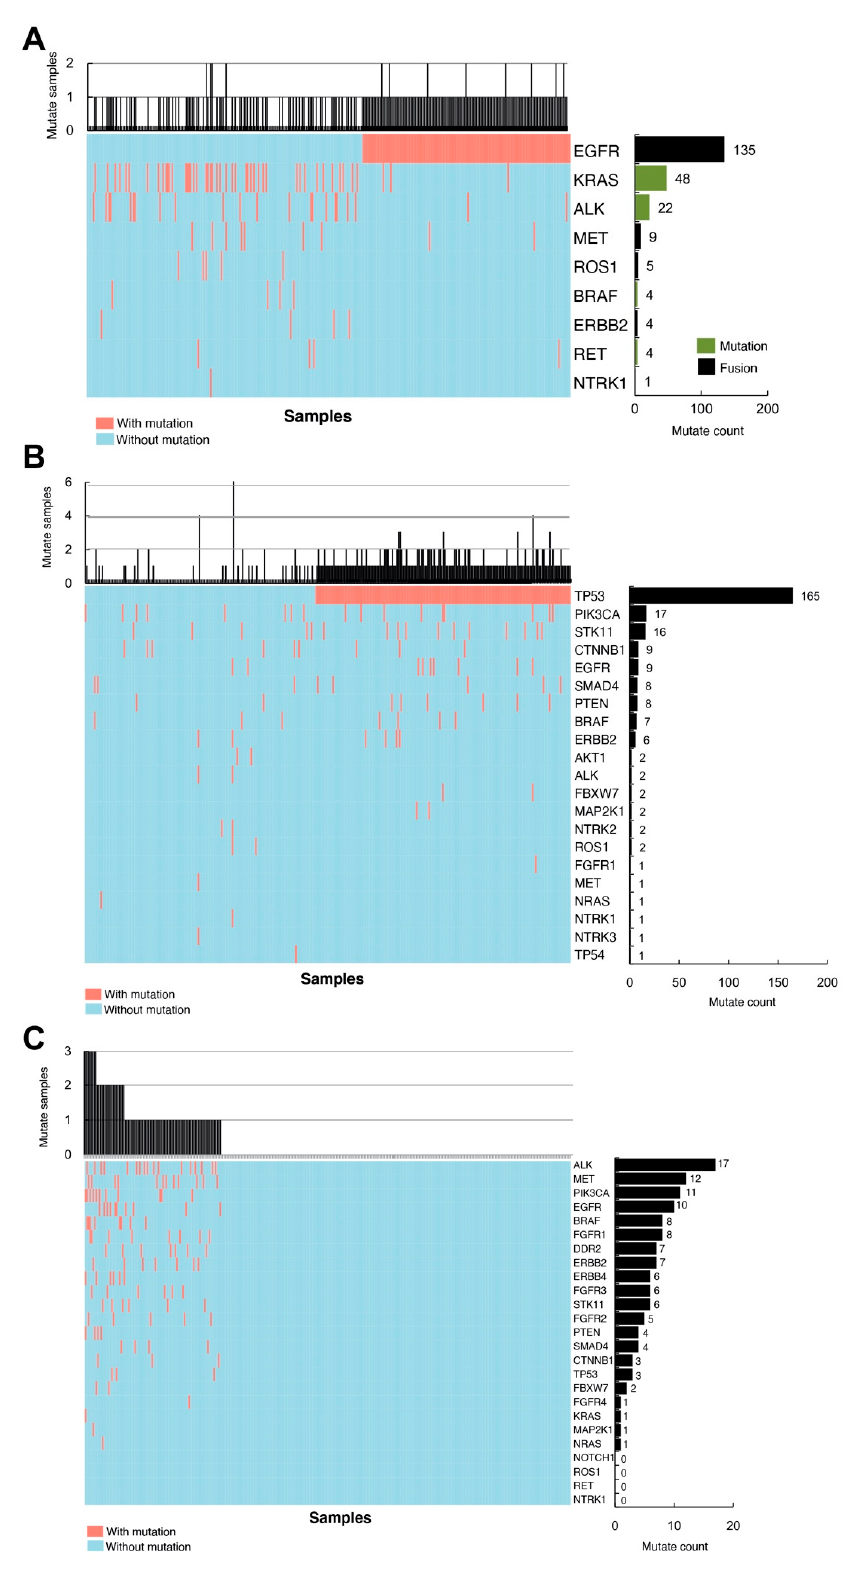
Figure 2. Mutation spectrum of different classes in Chinese lung cancer patients. ( A ) Class I mutations. EGFR has the highest mutation counts due to fusion in Class I. The black bar indicates mutations caused by gene fusion, and the green bar represents mutations due to other forms. ( B ) Class II mutations. TP53 mutations represent the highest count under Class II. ( C ) Class III mutations. ALK gene alteration is most frequently observed in this